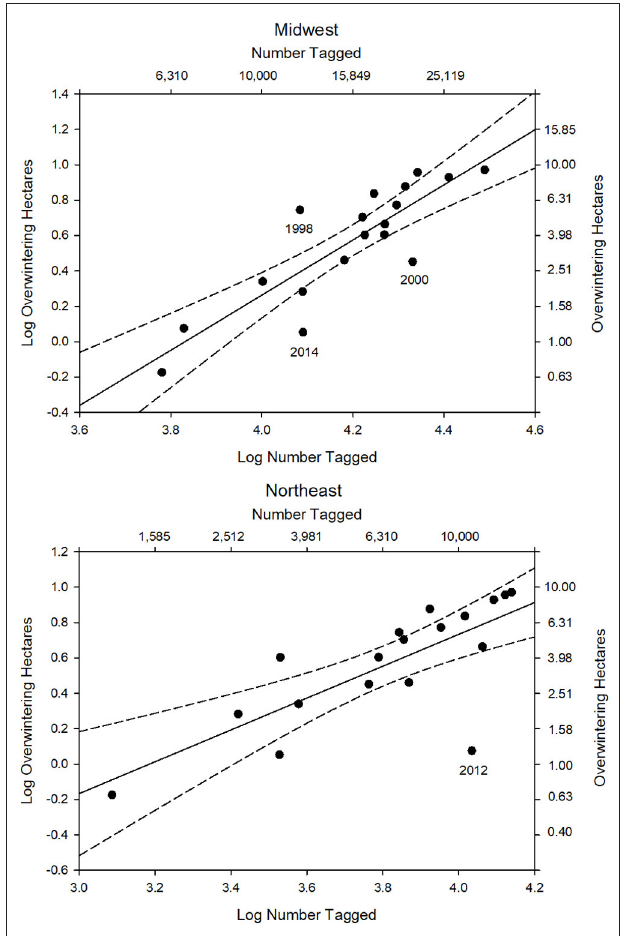
FIGURE 2 | Number of tagged individuals in the Midwest and Northeast (log) from 1998 to 2015 vs. overwintering population size (log hectares). For the Midwest R 2 = 0.74, p < 0.0001, n = 18 (log OW ha = − 5.98 + 1.56 log MW tag). For the Northeast R 2 = 0.58, p < 0.001, n = 18 (log OW ha = − 2.87 + 0.90 log NE tag). 95% confidence intervals